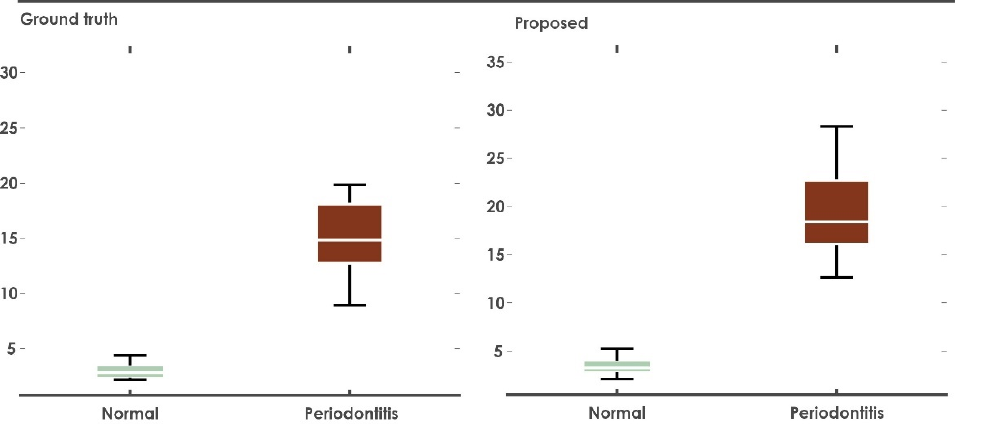
Figure 5. Box plot of ASA values obtained by computer tool and ground truth in radiographs of normal and periodontitis groups.